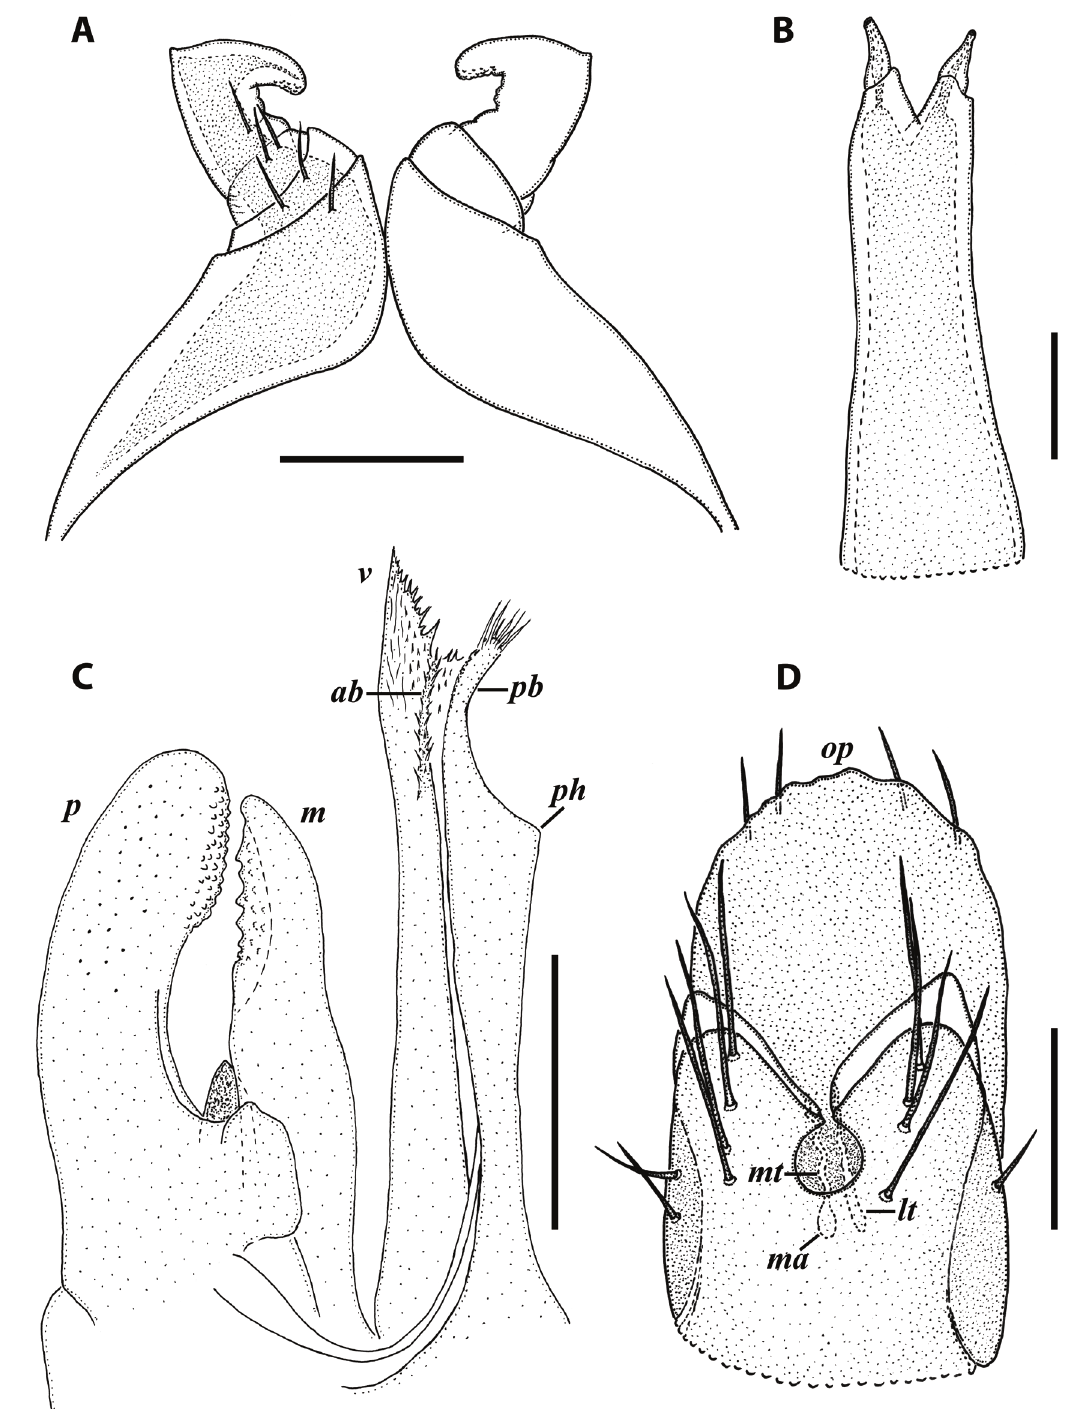
Fig. 5. Stygiiulus gentianae (Strasser, 1971) comb. et stat. nov., ♂ paralectotype (A–B) (MHNG), topotype ♂ (C) (NHMD) and topotype ♀ (D) (NHMD). A . Leg-pair 1, oral view. B . Penis, oral/caudal view. C . Left gonopods, mesal view. D . Left vulva, caudal, somewhat mesal view. Abbreviations: ab = anterior branch of solenomere; lt = lateral tube; m = mesomere; ma = median ampulla; mt = median tube; op = operculum; p = promere; pb = posterior branch of solenomere; ph = posterior hump; v = velum. Scale bars: A, C–D = 0.2 mm; B = 0.1